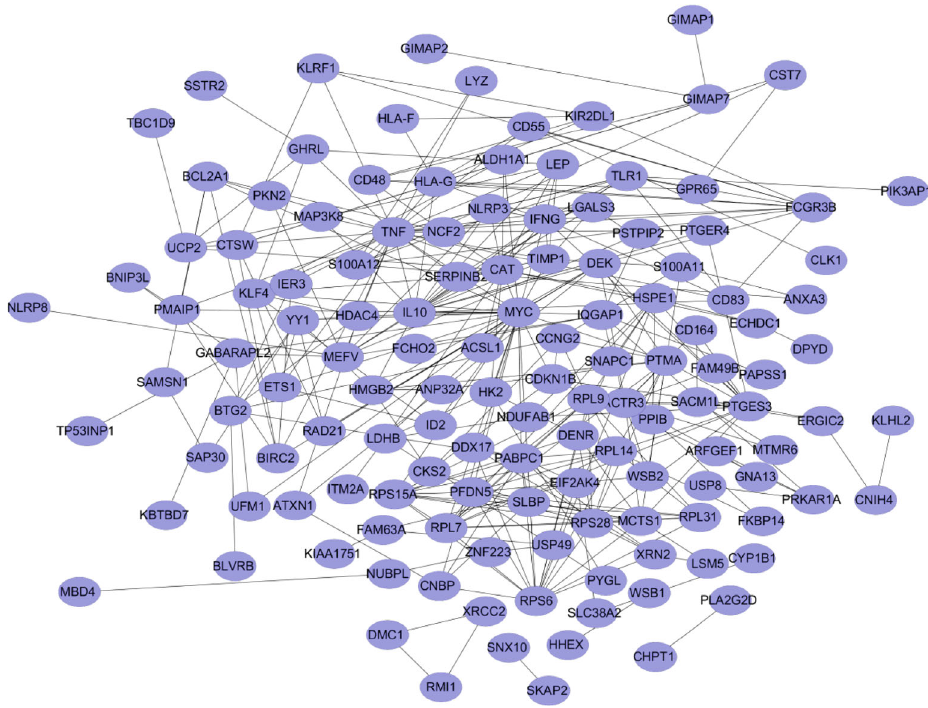
Figure 6: Protein-protein interaction (PPI) networks associated with di ff erences in female patients with IS.